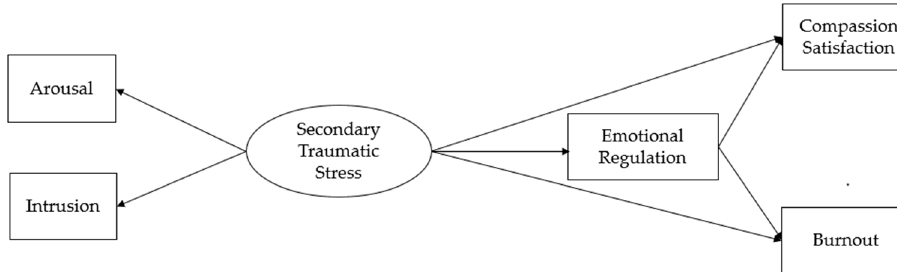
Figure 1. Hypothesized